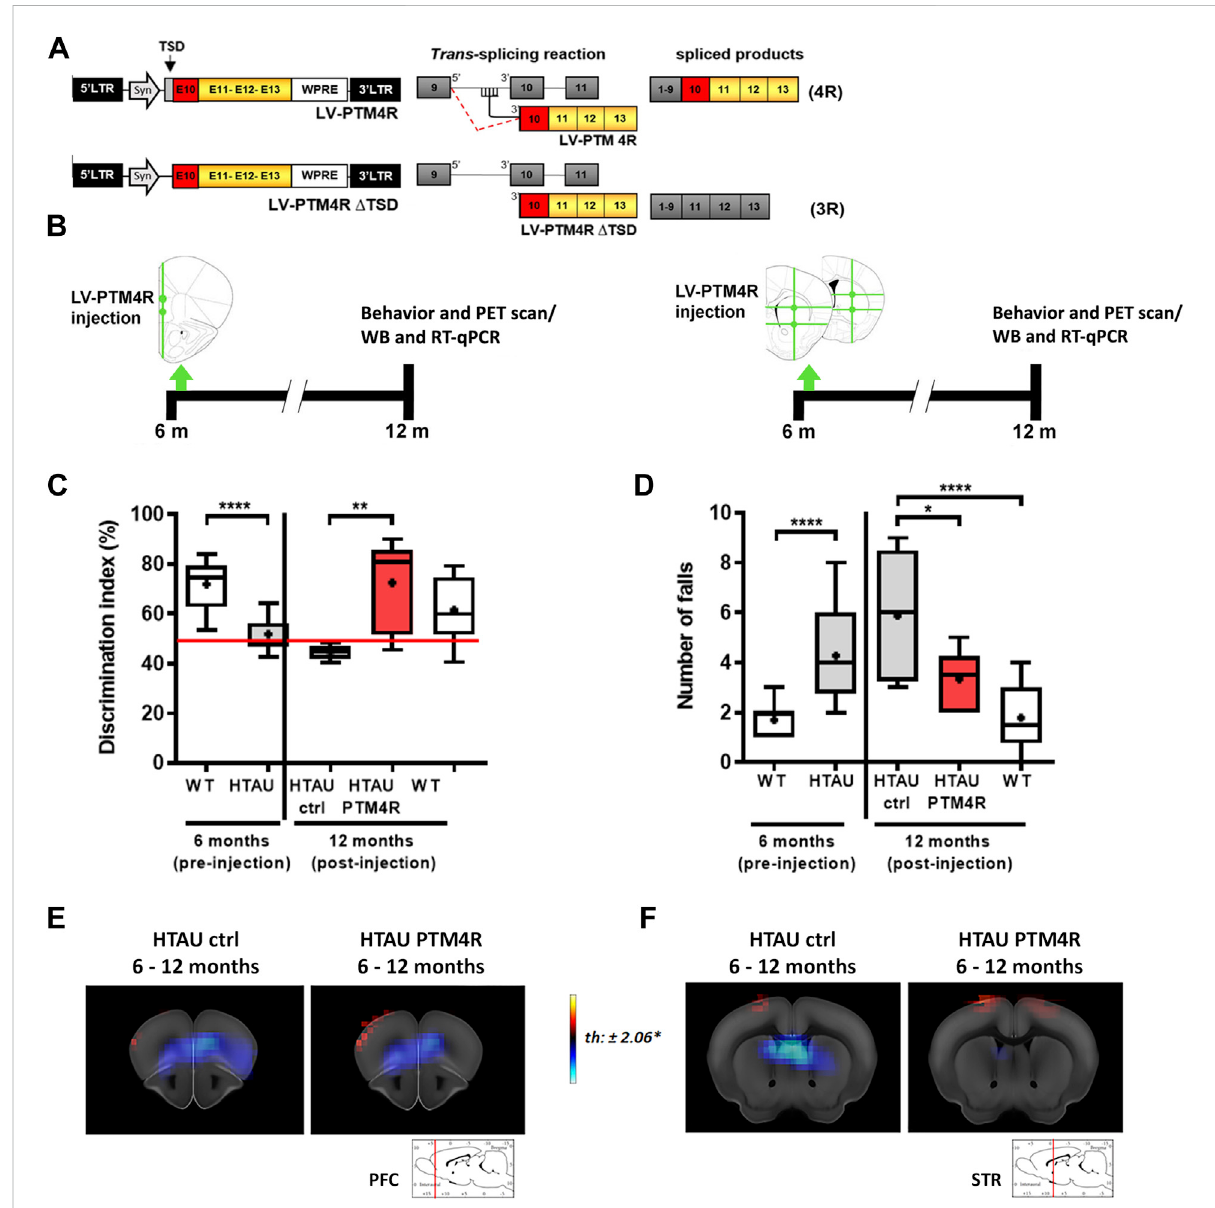
FIGURE 3 SMaRT rescues cognitive and motor de fi cits in htau mice. (A) Map of lentiviral vectors. LV-PTM4R used for trans-splicing and the expected chimerictranscriptcontainingE10.LentiviralvectorLV-PTM4R Δ TSDusedforcontrolmice. (B) Work fl owoftheexperimentsperformedtomodulate tau isoforms and evaluate phenotypic changes. Mice were bilaterally injected at 6 months old, either with PTM4R or control PTM4RDTSD into the prefrontal cortex at 2 ventral sites or into the striata at 2 anteroposterior sites, with 2 ventral sites each. (C) Novel object recognition task performed by htau mice before (6 months old, Unpaired t-test, **** p < 0.0001, WT n = 17, htau n = 21) and after (12 months old) PTM4R or control injection,comparedtoWTcontrols(1-wayANOVA,followedbyTukey ’ smultiplecomparisonstest,** p < 0.01,htaucontrol n =8,htauPTM4R n =10, WT control n = 15). (D) Total number of falls in the rotarod before PTM injection (6 months-old; unpaired t-test, **** p < 0.0001, WT n = 23, htau n = 25) and post-injection (12 months-old; 1-way ANOVA, followed by Tukey ’ s multiple comparisons test, * p < 0.05, **** p < 0.0001, htau control n = 9, htau PTM4R n = 8, WT control n = 16) indicating that PTM4R htau mice showed a considerable reduction in falls, similar to WT, compared to their htau controls. (E , F) In vivo FDG-PET imaging of brain glucose uptake analysed at 12-month-old PTM4R or control htau mice compared to brain glucose uptake at 6 months old (before PTM injection). Red-yellow look up table side indicates [18F]-FDG uptake increases, while blue indicates uptakedecrease. (E) PTM4Randcontrolhtaugroupsdidnotshowsigni fi cantdifferenceinthemPFCbrainglucoseuptake( n =8 – 10). (F) Striatalbrain glucose uptake of PTM4R htau showed differences when compared to htau control ( n = 8 – 9). T values for p < 0.05 are speci fi ed for each comparison. Images shown represent T-maps of brain metabolism compared to earlier recorded activity of the same